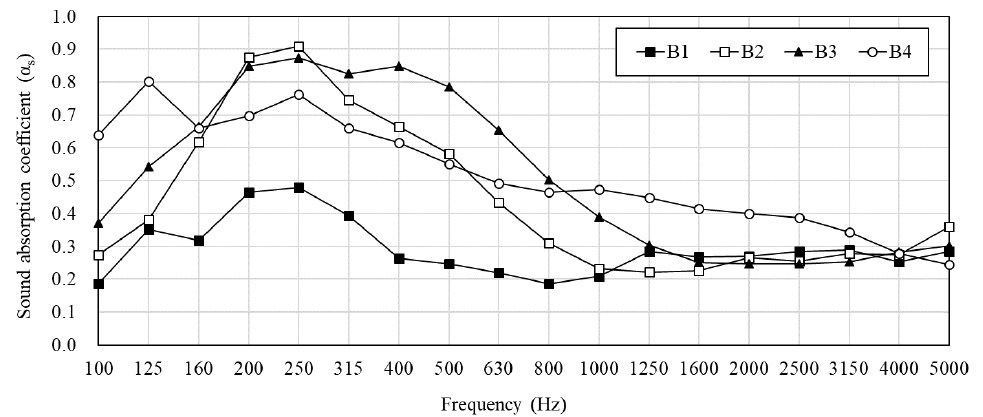
Figure 10. The sound absorption coefficient of Group B in stage 2 (specimen height 20 cm). B1: canvas with 15.8 cm air-layer + EMM with 3 cm air-layer. B2: canvas with 8.8 cm air-layer + EMM with 10 cm air-layer. B3: canvas with 3.8 cm air-layer + EMM with 15 cm air-layer. B4: canvas with 0 cm air-layer + EMM with 20 cm air-layer.